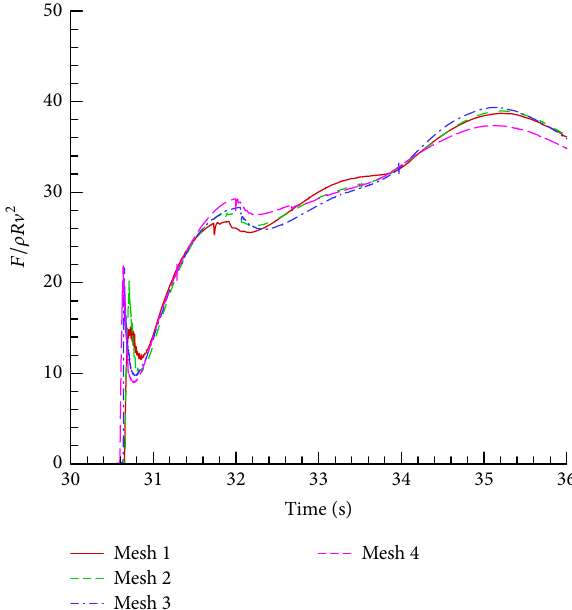
Figure 5: Hydrodynamic forces on the circular cylinder with different mesh size.